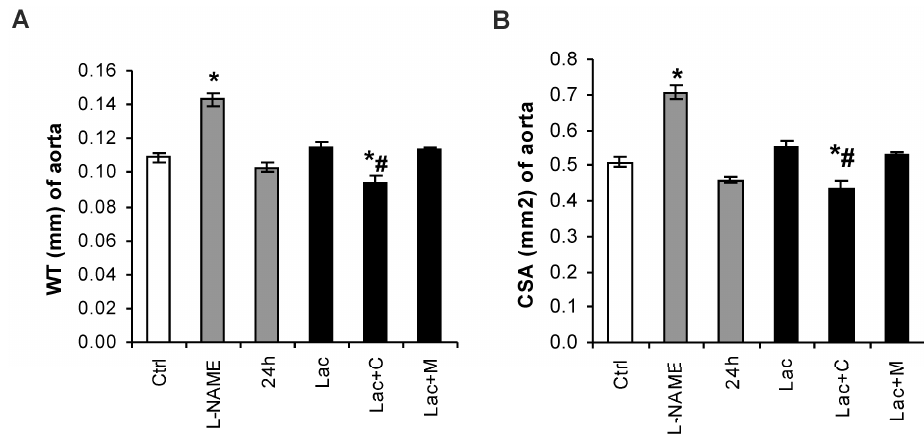
Figure 2. Aortic thickness (WT) ( A ) and cross sectional area (CSA) ( B ) in the control group (Ctrl), L-NAME (L-NAME)-, continuous 24 h/day light (24 h)-, lactacystin (Lac)-induced hypertension, and in lactacystin-hypertension influenced by captopril (Lac+C) or melatonin (Lac+M). * p < 0.05 vs. Ctrl, # p < 0.05 vs. Lac.